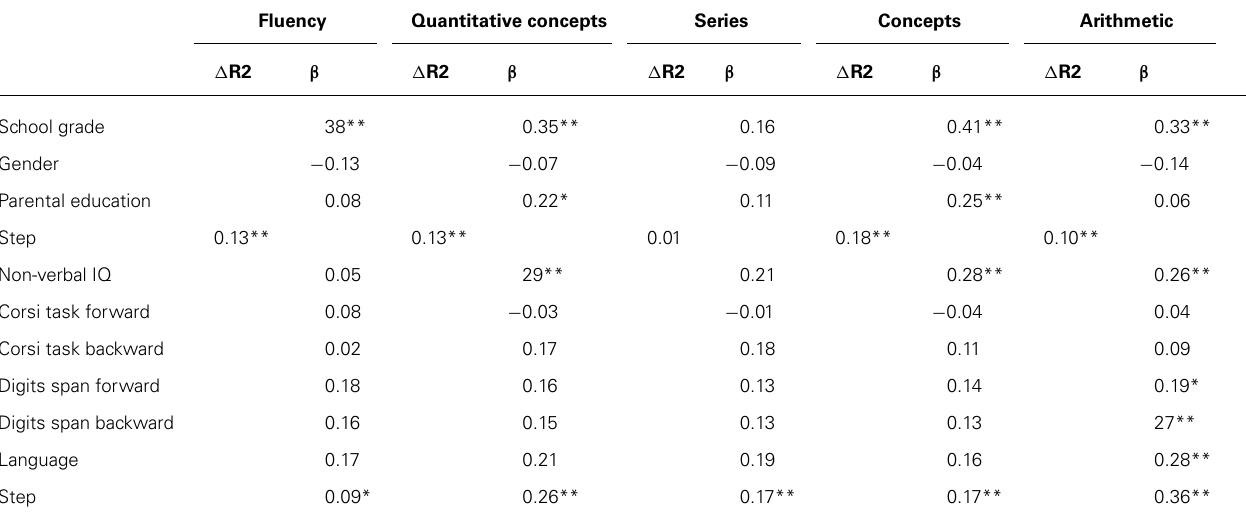
Table 4 | Results of hierarchical regression